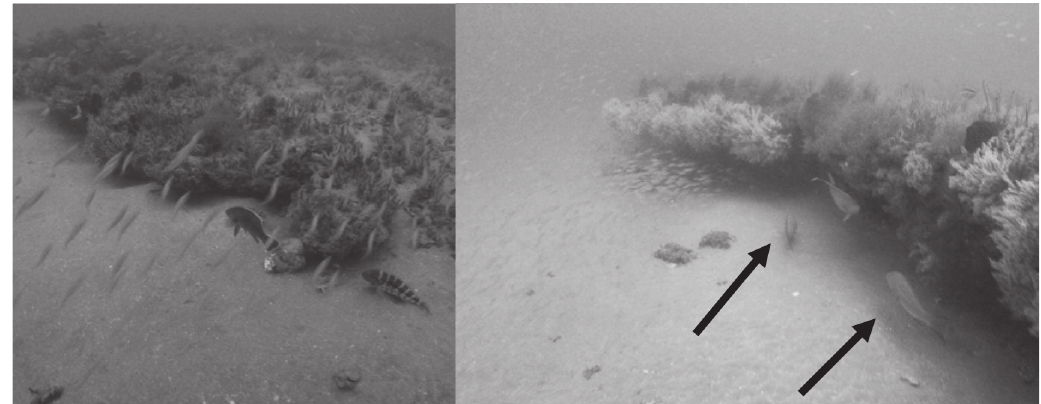
Fig. 2 . Black sea bass Centropristis striata and bank sea bass Centropristis ocyurus (left) in typical orientation at edge of ledge before ambush feeding on prey fish. Two scamp Mycteroperca phenax (right, indicated by arrows) along ledge move towards high density aggregation of prey fishes. Mycteroperca phenax attacked prey fishes subsequent to this photograph.